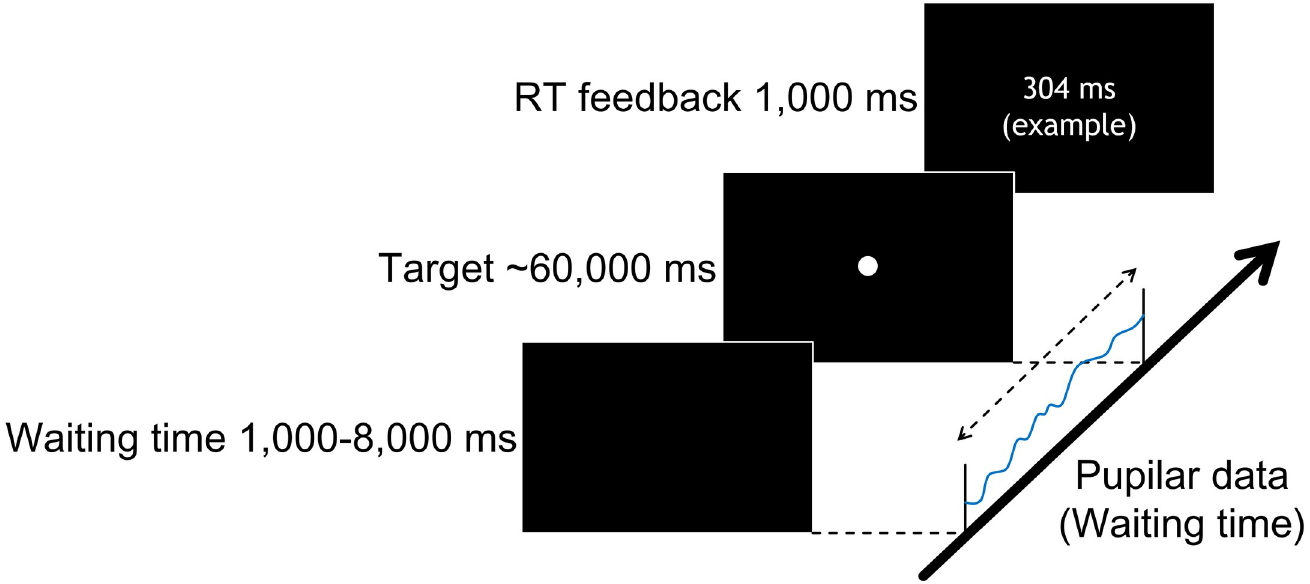
Fig 2. The serial flow of elements in one trial of the Psychomotor Vigilance Task. After a random interval (1,000 to 8,000 ms), a target (white dot) appeared. Participants were asked to press a key for the appearance of the target as quickly as possible. After the keypress response, the time from the appearance of the target to the keypress was displayed. The section for measuring the pupilar diameter is illustrated (from the start of the trial to the target appearance).